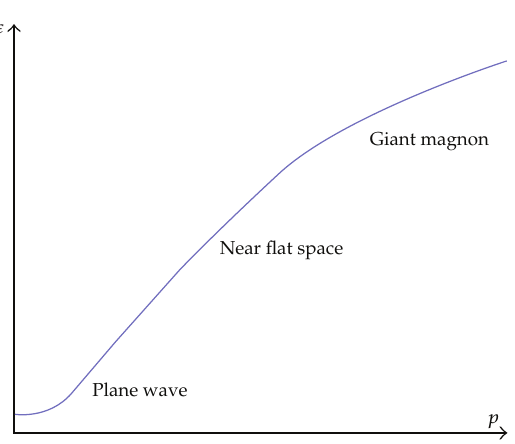
Figure 6: Near-flat-space limit. It interpolates between the plane wave regime and the giant magnon regime. The diagram shows the energy as a function of the momentum. In the plane wave limit the momentum p scales as ∼ λ − 1 / 2 , in the NFS region p ∼ λ − 1 / 4 and finally in the giant magnon regime p is a constant (cid:3) an angle (cid:4)